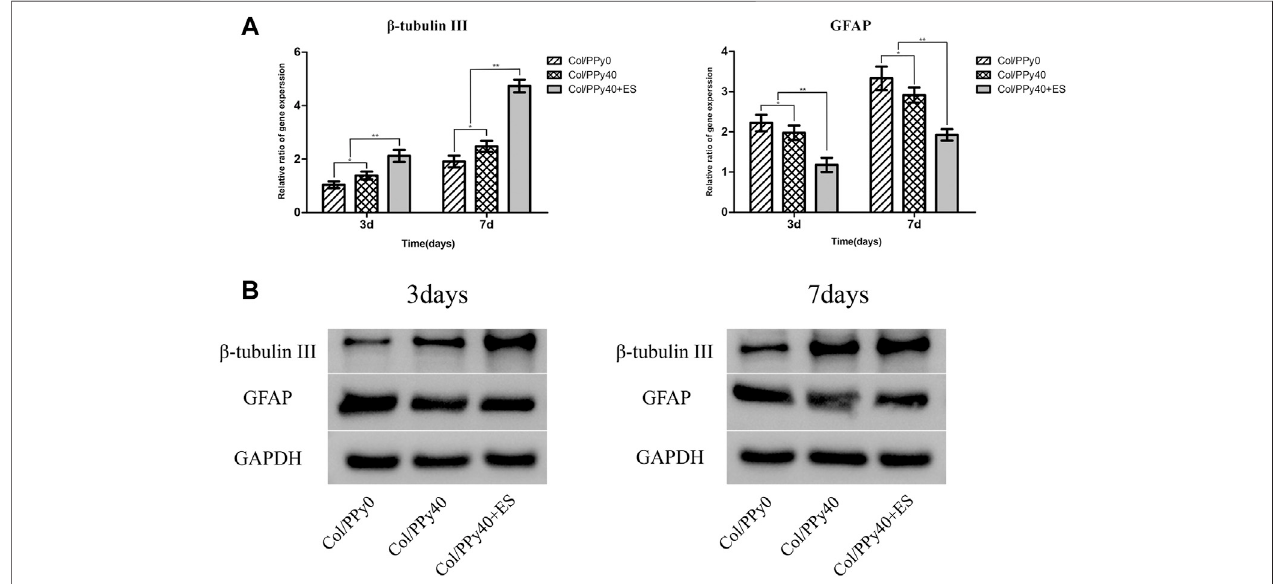
FIGURE 8 | Gene (A) and protein (B) expression levels of β -tubulinIII and GFAP of the NSCs differentiated in Col/PPy0, Col/PPy40 and Col/PPy40 + ES (200 mV) groups on day 3 and day 7.